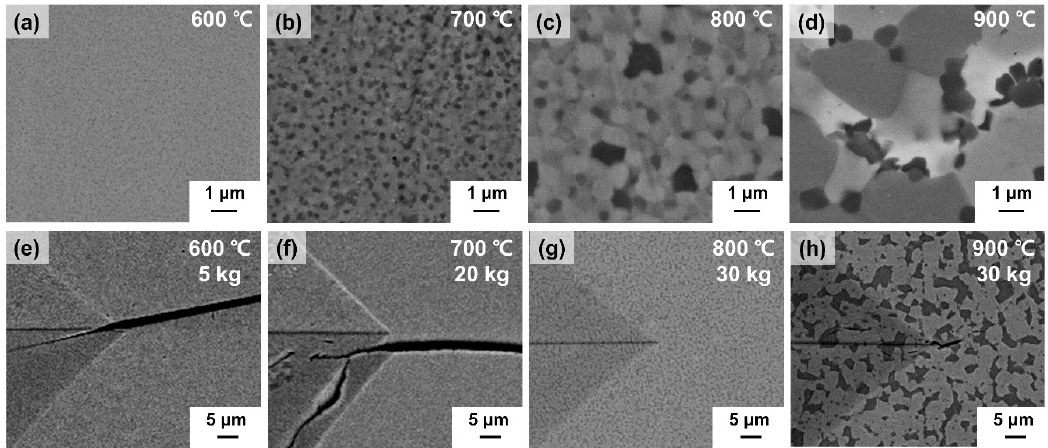
Figure 7. ( a – c ) SEM images of grain size di ff erence according to annealing temperature in crystallization targets after heat treatment at ( a ) 600, ( b ) 700, ( c ) 800, and ( d ) 900 ◦ C. ( e – h ) SEM images after hardness testing of crystallization targets subjected to di ff erent annealing temperatures: ( e ) 600, ( f ) 700, ( g ) 800, and ( h ) 900 ◦